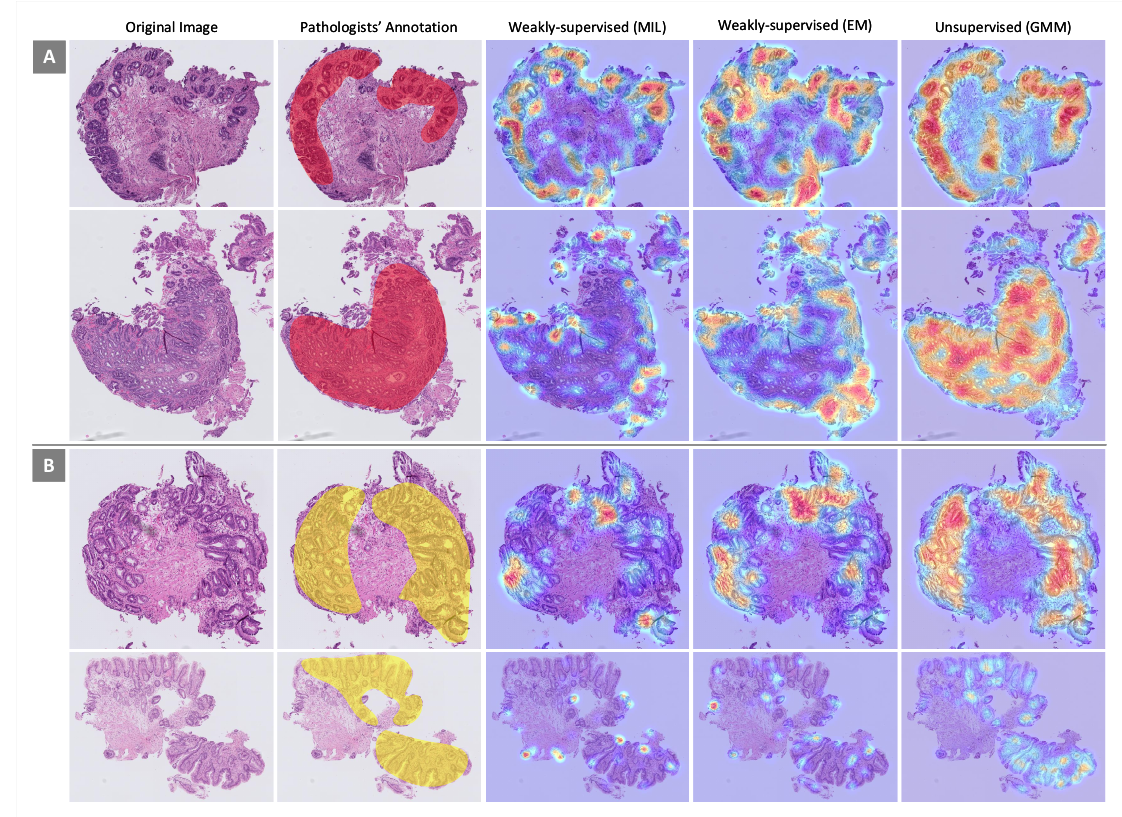
Figure 7. Heatmaps generated by different feature extraction approaches for some samples from ( A ) dysplastic Barrett’s esophagus (BE) and ( B ) non-dysplastic BE. Area of attention is shown in